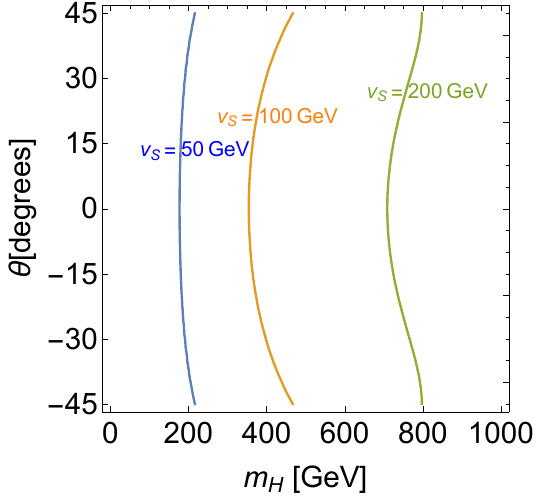
Figure 10 . Constraints from perturbative unitarity in the ( m H , θ ) plane for v S = 50 GeV (blue), 100 GeV (orange) and 200 GeV